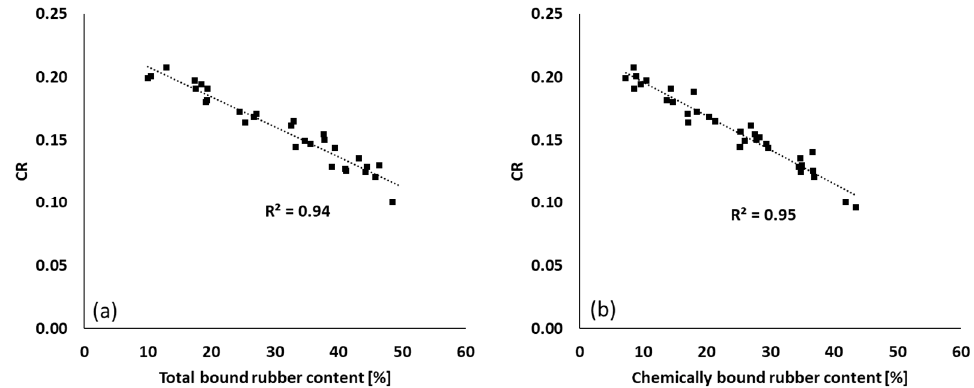
Figure 9. CR vs. bound rubber content: ( a ) CR vs. total bound rubber and ( b ) CR vs. chemically bound rubber; fitting lines for ( a , b ) are based on linear fit with maximum R 2 .